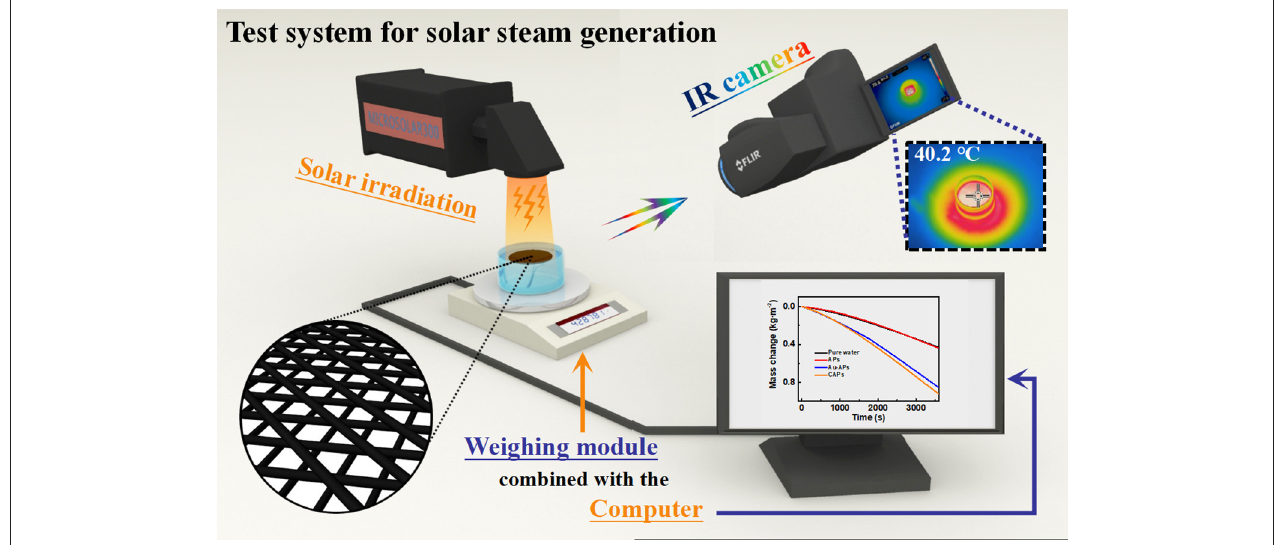
FIGURE 2 | The schematic diagram of the test system for solar steam generation ability. Bottom left corner: the schematic of the free-floating CMs on the water contained in a weighing bottle; Top right corner: the IR image of the CMs under illumination.